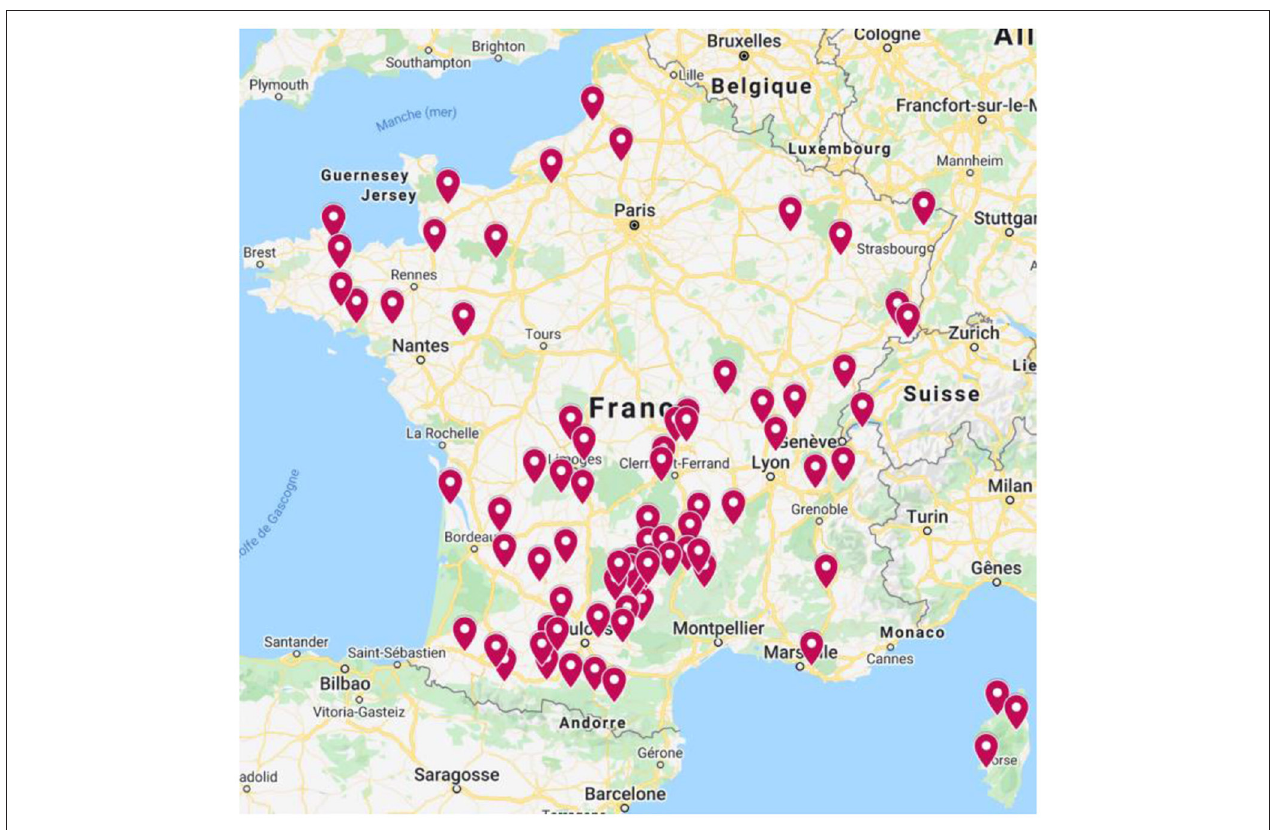
FIGURE 1 | Breakdown of responding veterinarians in Metropolitan France